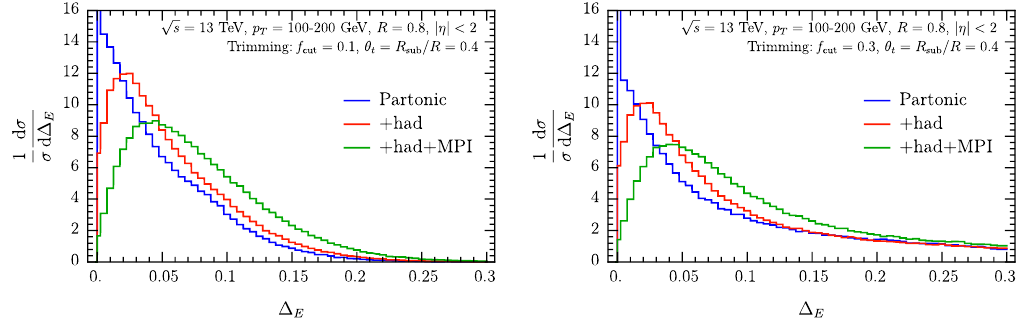
Figure 23 . Pythia results for the jet energy drop with trimming for f cut = 0 . 1 (left panel) and f cut = 0 . 3 , at parton level (blue), hadron level (red), and including MPI (green). Note that these curves are normalized on the full ∆ E interval.